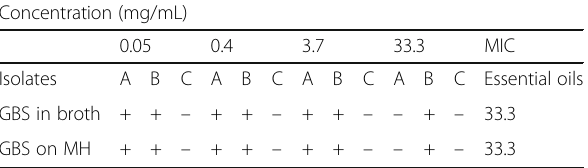
Table 5 MIC for essential oils against GBS